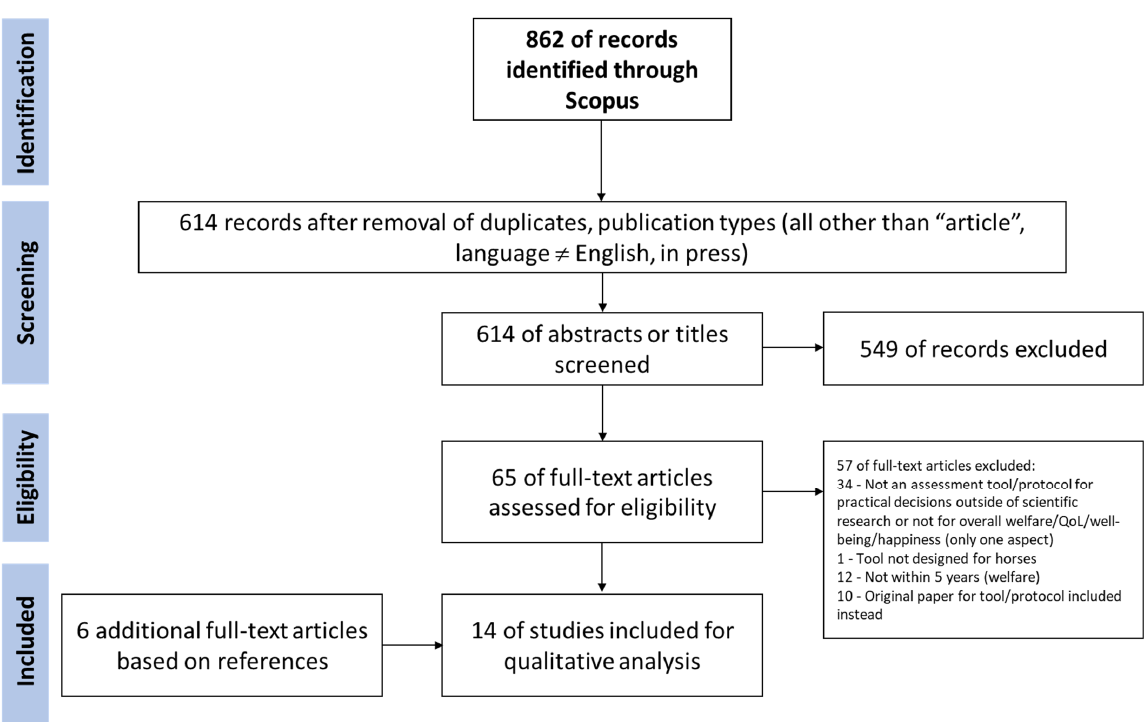
Figure 1. Flow chart illustrating the selection of studies included in the review.